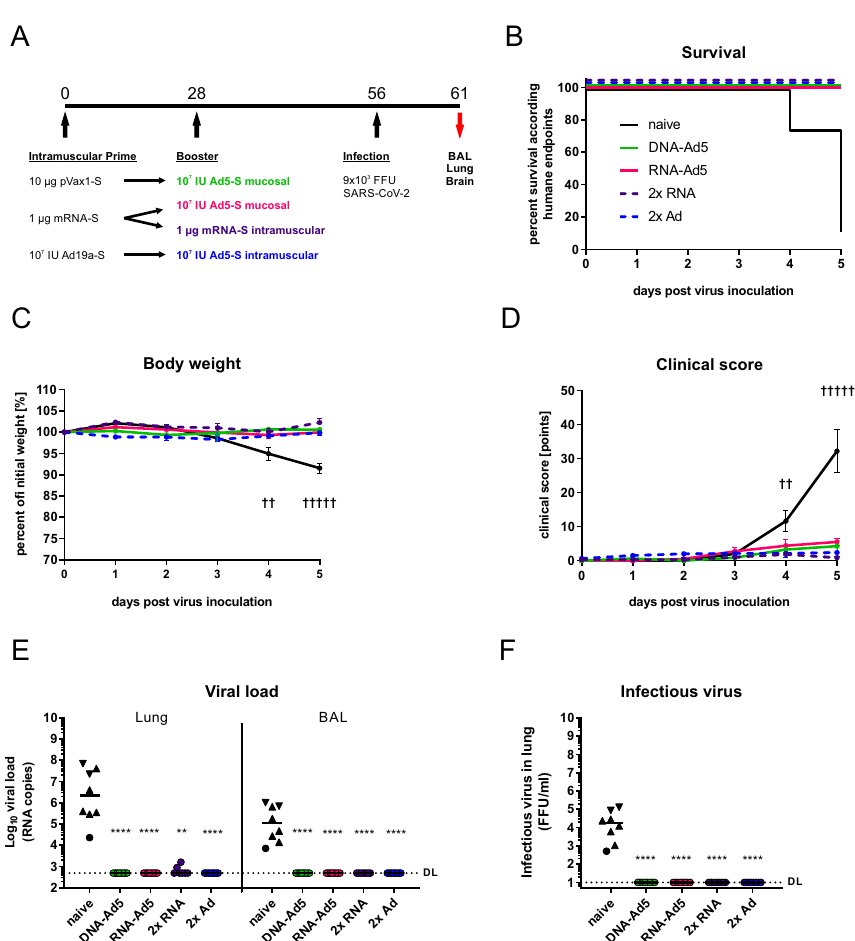
Fig. 10 Protective ef fi cacy against SARS-CoV-2 infection. A K18-hACE2 mice (2x RNA n = 7, other groups n = 8) received an intramuscular prime immunization with the spike-encoding DNA (10 µ g) followed by electroporation, Ad19a-S (10 7 infectious units), or the mRNA vaccine, Comirnaty ® (1 µ g). Mice from the heterologous prime-boost groups were boosted four weeks later intranasally or intramuscularly with Ad5-S (10 7 infectious units). The 2x RNA group received a second dose of mRNA (1 µ g) intramuscularly. Four weeks after the boost immunization, mice were infected intranasally with 9 × 10 3 FFU SARS-CoV-2. All animals were monitored daily for survival ( B ), body weight ( C ), and clinical score ( D ). Curves in ( C ) and ( D ) represent group means with SEM. Animals reaching humane endpoints were euthanized and are marked by a cross at the respective time point. Viral RNA copy numbers were assessed in lung homogenates and BAL samples by qRT-PCR ( E ) and infectious virus was retrieved and titrated from lung homogenates ( F ). Data points shown represent viral copy number or virus titre of each animal with the median of each group, whereby circles indicate a survival of 5 days post infection and triangles indicates euthanized mouse according humane endpoints at day 4 (triangle pointing down) or day 5 (triangle pointing up). The dashed line indicates the lower limit of detection. Data were analysed by Kruskal – Wallis test (one-way ANOVA) and Dunn ’ s Pairwise Multiple Comparison Procedures as post hoc test in comparison to PBS control; p values indicate signi fi cant differences (* p < 0.05; ** p < 0.005; *** p < 0.0005; **** p <